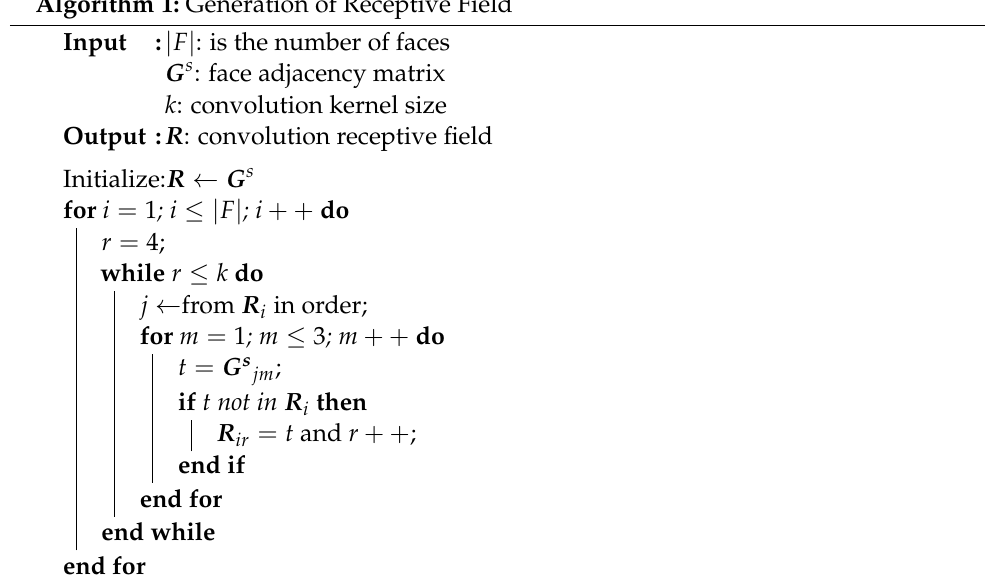
Algorithm 1: Generation of Receptive